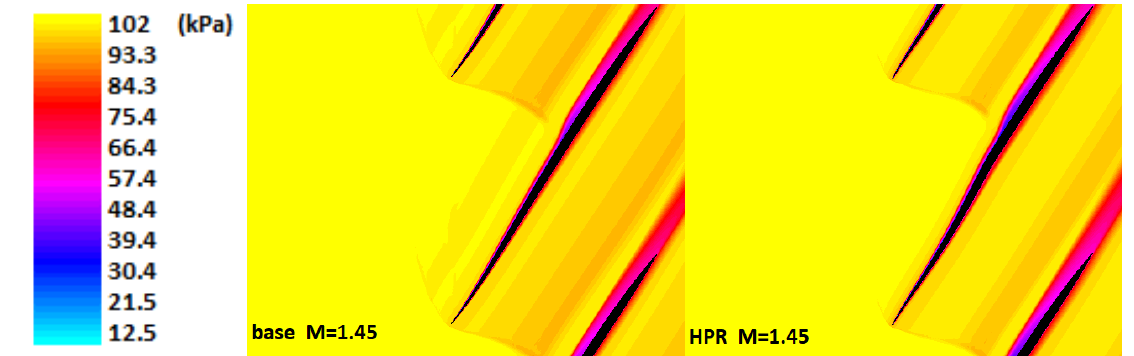
Figure 21. Total pressure contours (kPa) of profiles with HPR at Mach